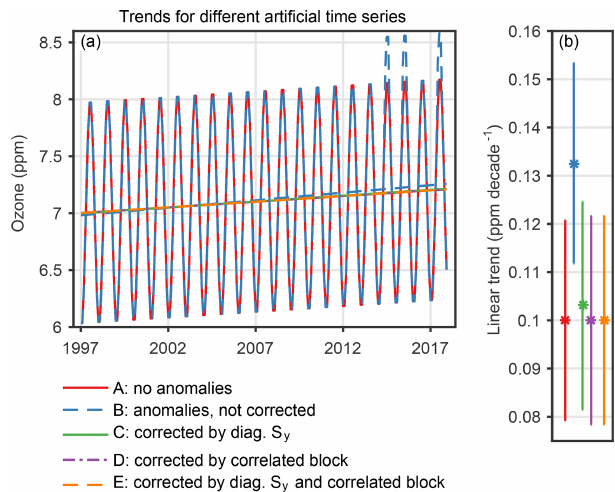
Figure 6. (a) Ozone time series and linear trends for the same arti- ficial ozone time series as in Fig. 5 (case A). Anomalies were added to the time series in the summer months 2014, 2015, and 2017 in case B. Different corrections have been applied to account for those anomalies in the trend fit, represented by cases C to E. (b) Linear trend estimates for the time series without anomalies (case A) and the time series with added anomalies, for which the anomalies were considered in different ways (cases C, D, E) or not considered at all (case B). The error bars show 2 standard deviation ( σ ) uncertainties.